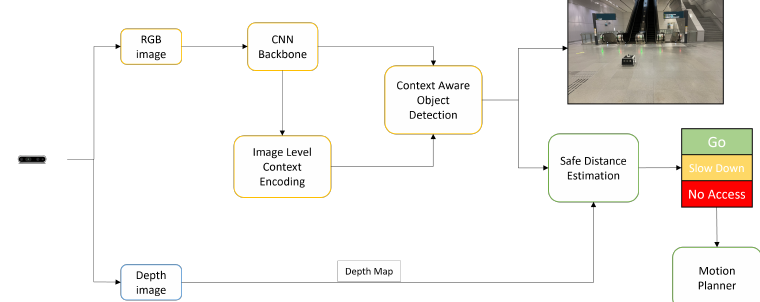
Figure 1. Block diagram of proposed system.